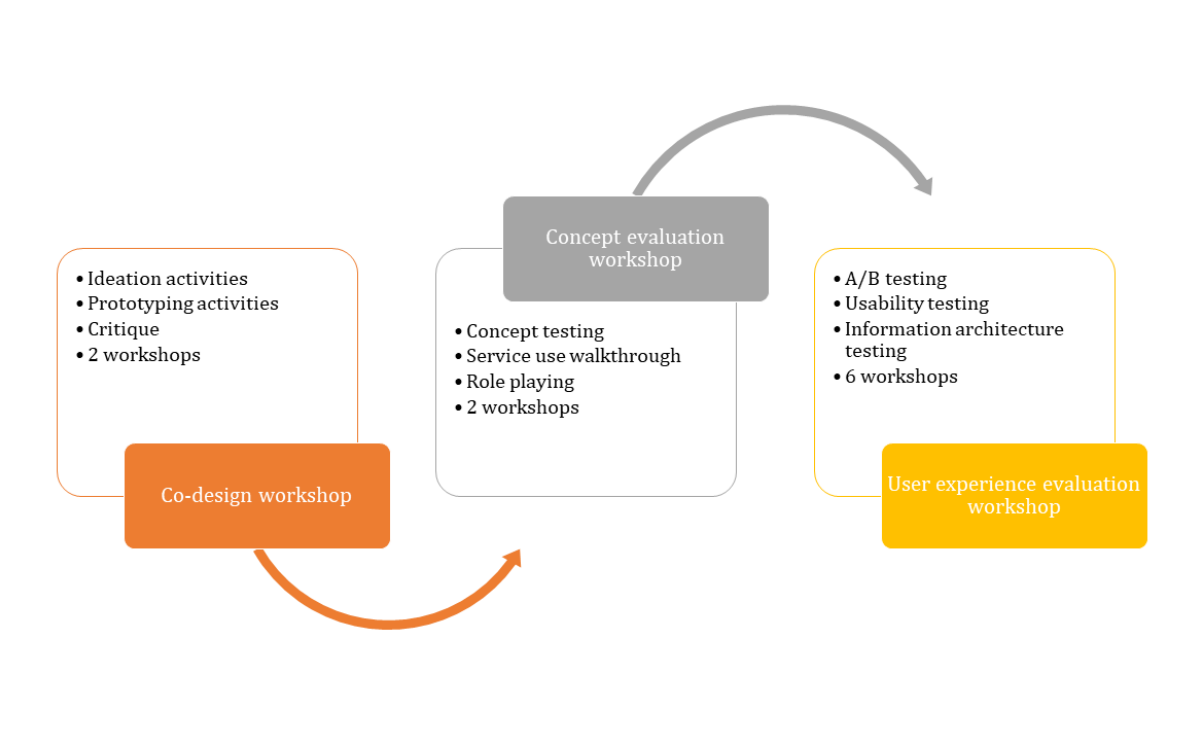
Figure 2. Iterative design